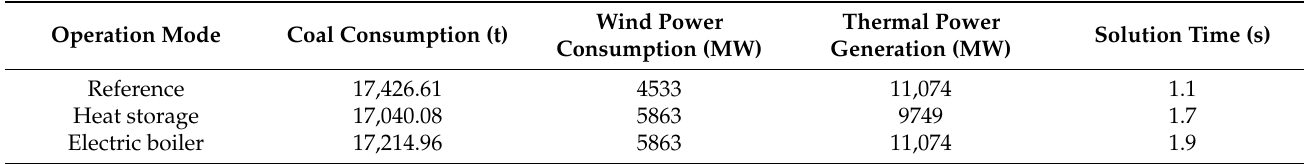
Table 9. Scheduling results of different operating modes.